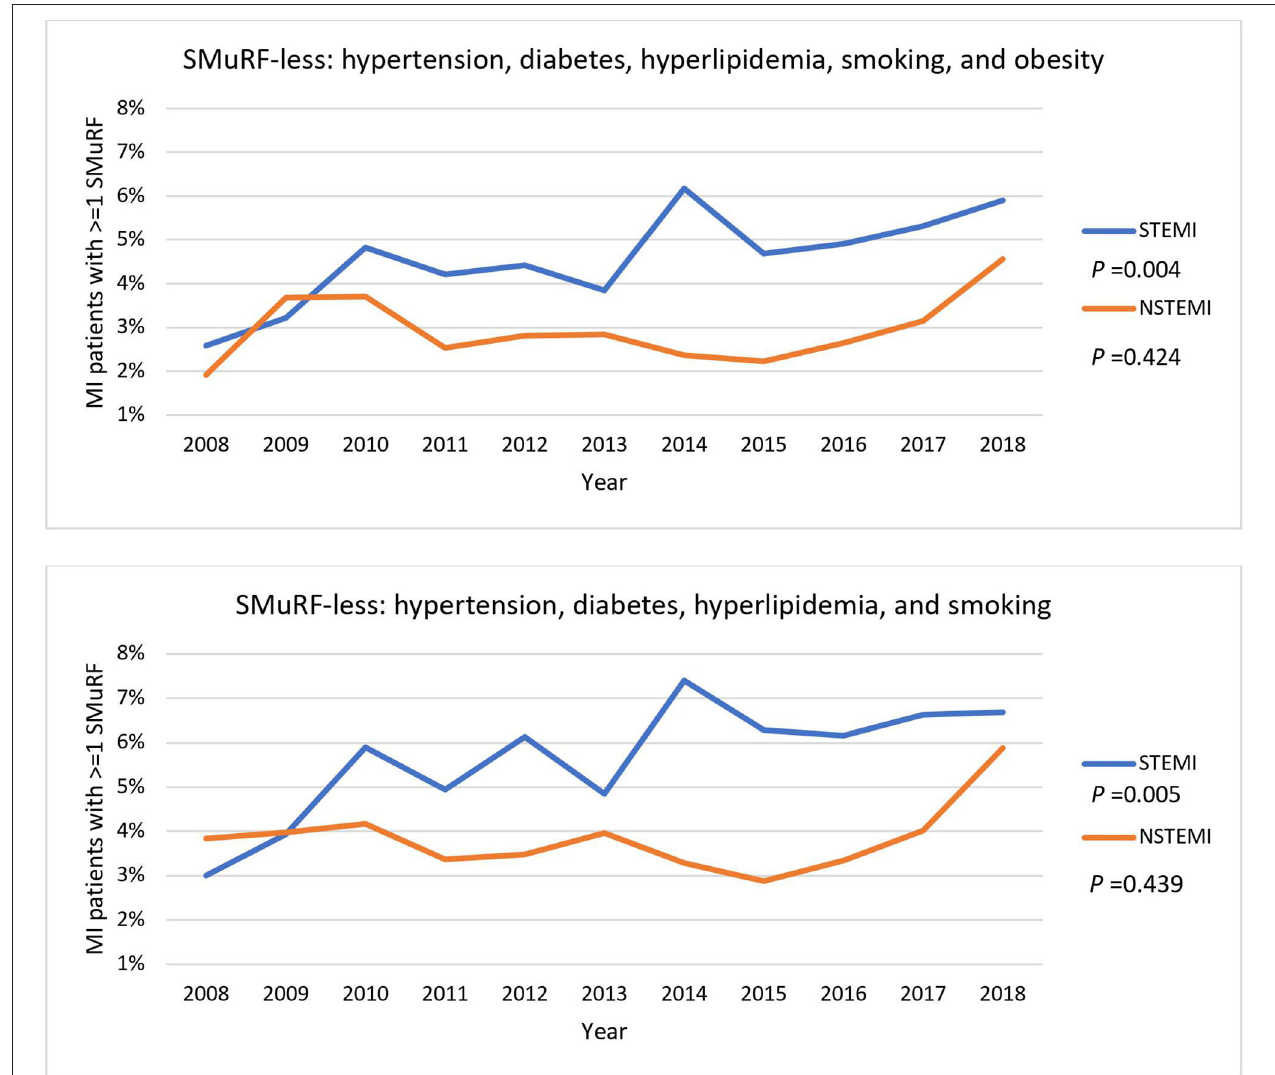
FIGURE 2 | General trends of STEMI and NSTEMI patients without SMuRF from 2008 to 2018. Percentages of STEMI and NSTEMI patients with one or more of SMuRF were traced from 2008 to 2018. Obesity was included as one of the SMuRF (top) or excluded (bottom). The P- values represent the statistical significance for the overall trend of STEMI and